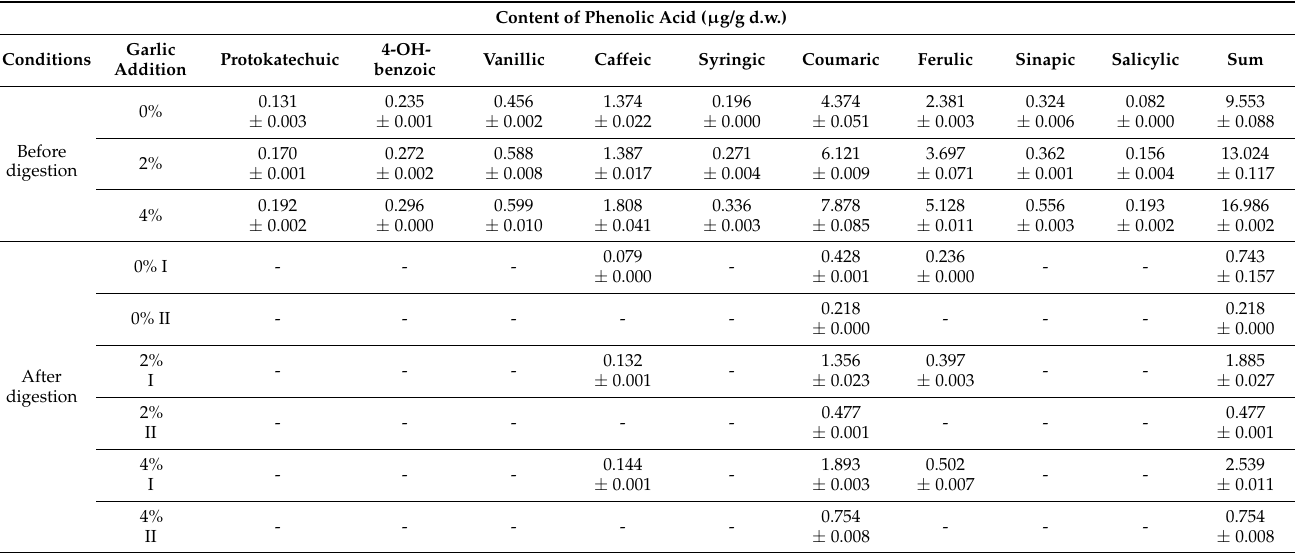
Table 6. The content of phenolic acids (without hydrolysis) in snacks enriched with wild garlic extruded at 120 rpm (n = 3; mean ± SD); I- gastric digestion stage, II- duodendal digestion stage. Content of Phenolic Acid ( µ g/g